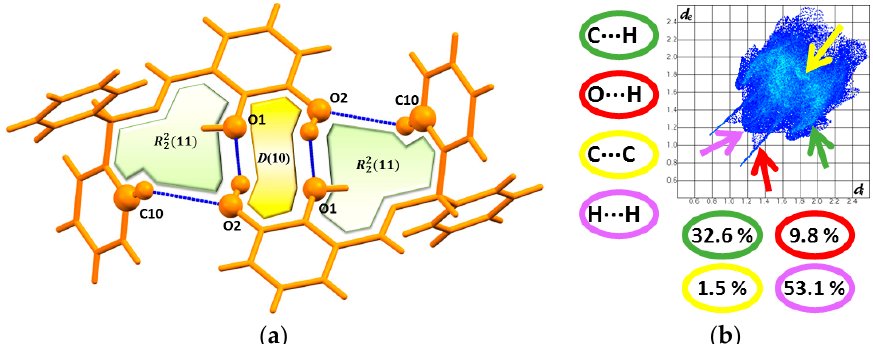
Figure 3. View of ( a ) a centrosymmetric dimer of oOHsaladpm molecules formed by means of O–H···O and C–H···O interactions and ( b ) the 2D-fingerprint plot with marked corresponding regions: green arrow for C···H contacts, red arrows for O···H contacts, yellow arrow for C···C contacts and violet arrow for H···H contacts.